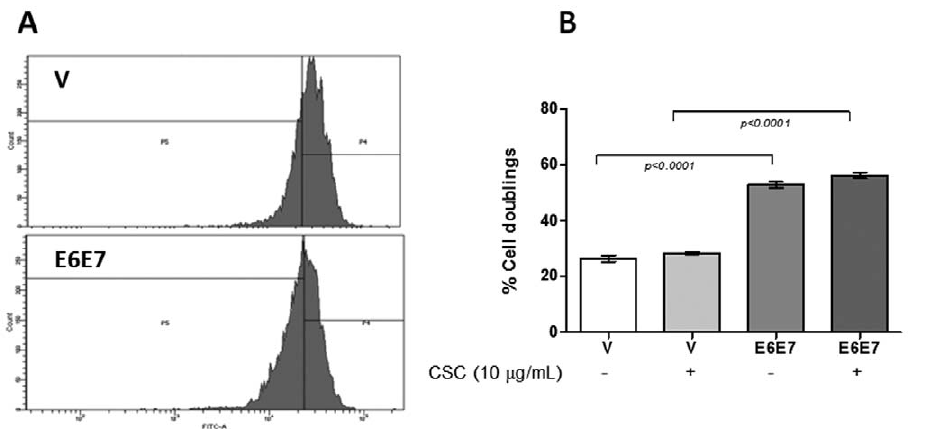
Figure 8. HPV-16 E6 and E7 expression in A549 (A) and BEAS-2B (B) cells exposed to CSC promotes an increased anchorage- independent growth. Below: Number of colonies per plate in A549 (left) and BEAS-2B (right) (mean 6 SD, unpaired two-tailed Student’s t-test. Each plate is representative of three independent experiments).